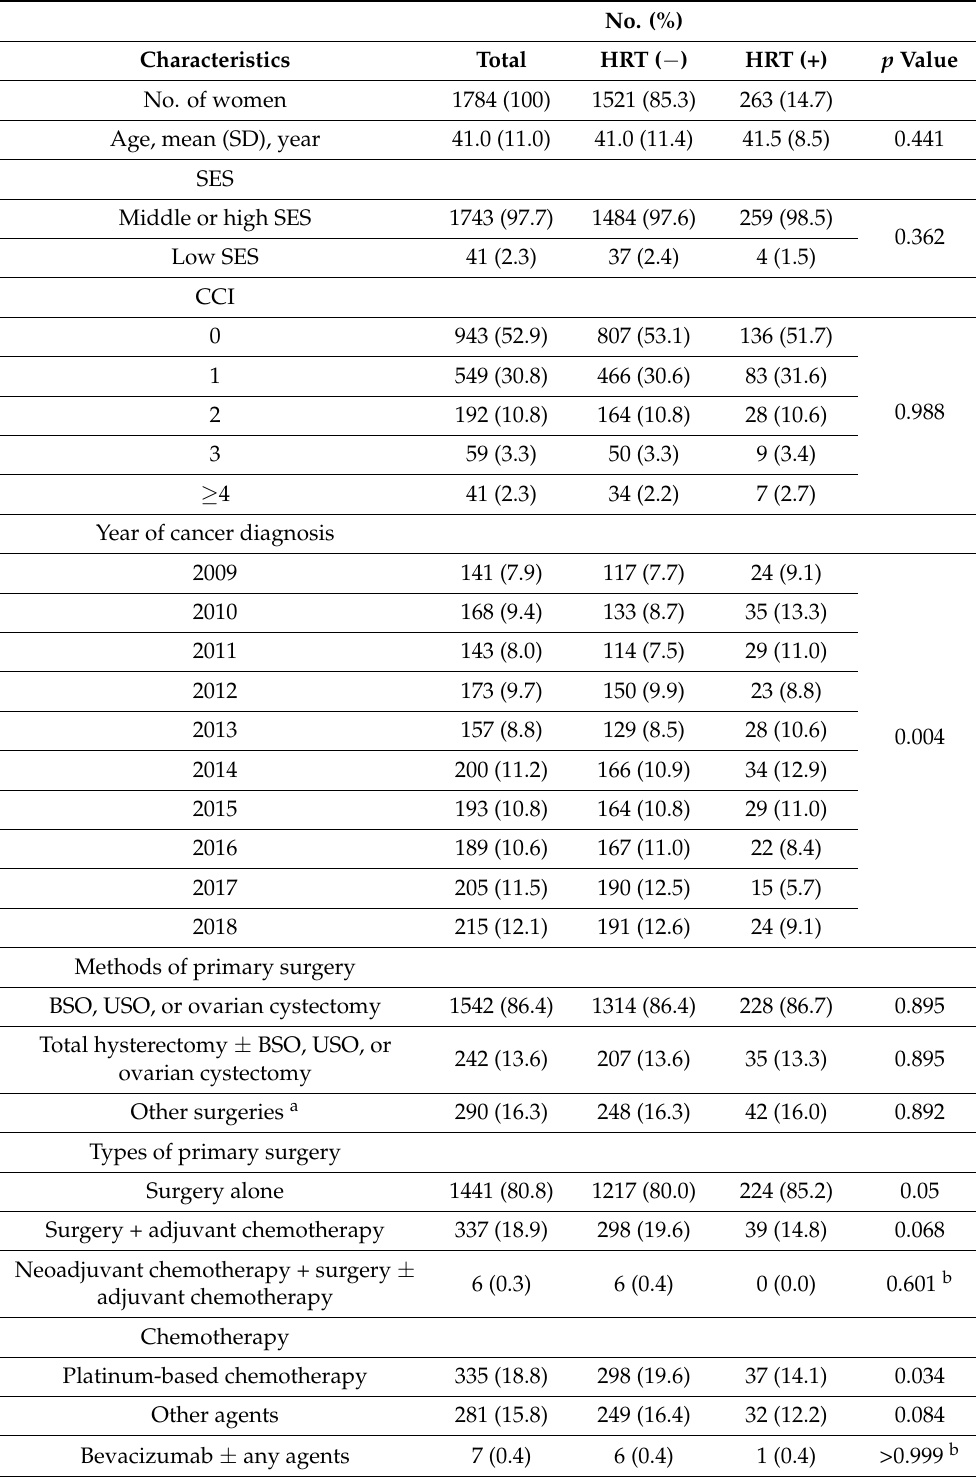
Table 1. Characteristics of women with ovarian cancer according to HRT